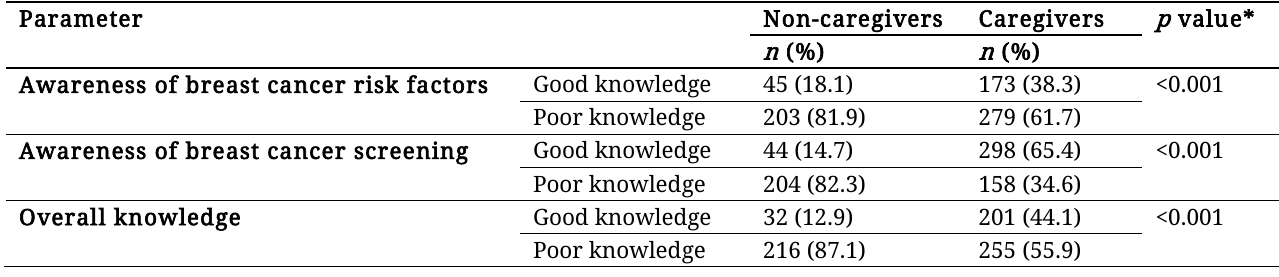
Table 3: Comparison of knowledge between non-caregivers and caregivers